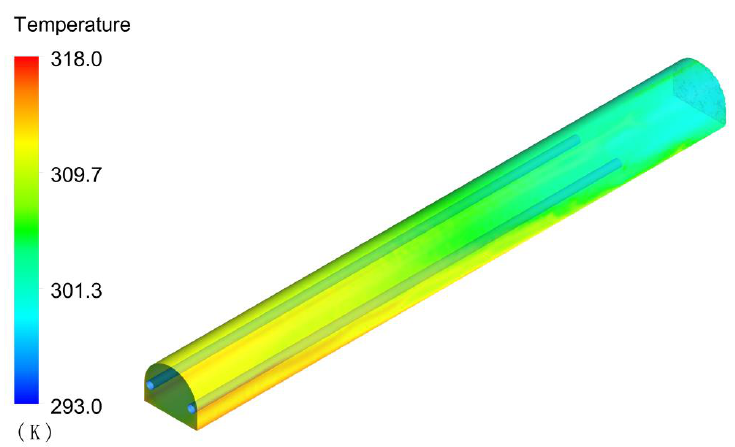
Figure 17. Model 5 roadway temperature side view (x = 0).